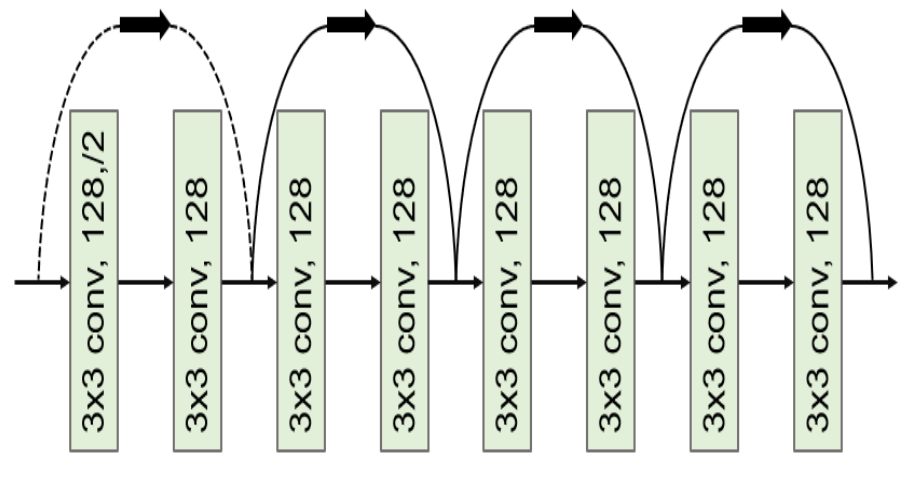
Figure 3. A common ResNet block